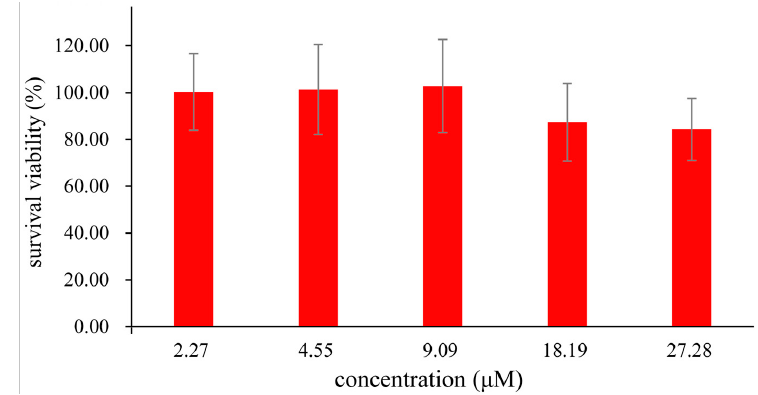
Figure 7. MTS assay of HepG2 cells incubated in the presence of the probe (0–27 μ M) at 37 °C for 24 h.